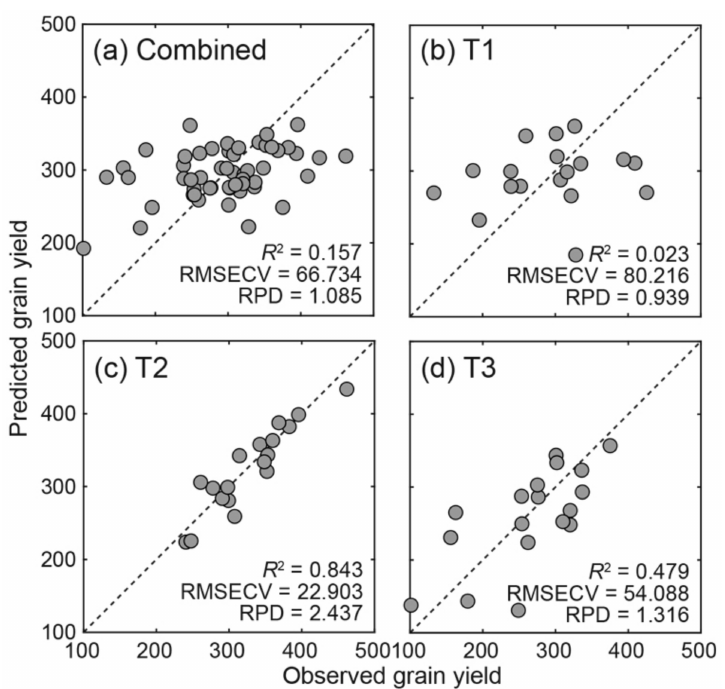
Figure 6. Observed and cross-validated predicted values of rice grain yield ( a – d ) using ISE-PLS regression for the combined ( n = 54) and T1, T2 and T3 data sets ( n = 18), respectively (see Table